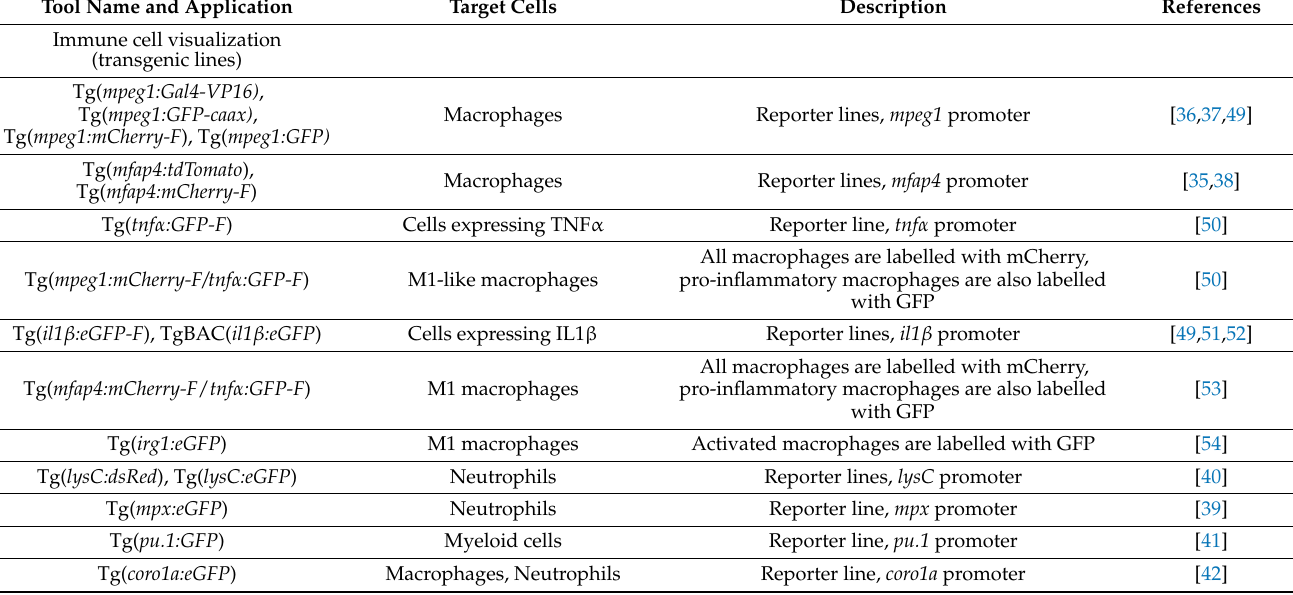
Table 1. Tools generated to study the cellular components of inflammation in zebrafish, including fluorescent reporter lines, morpholinos, mutants, and systems to deplete or enrich specific immune cell populations. Tg: transgenic line; MO: morpholino; mRNA: mRNA microinjection.